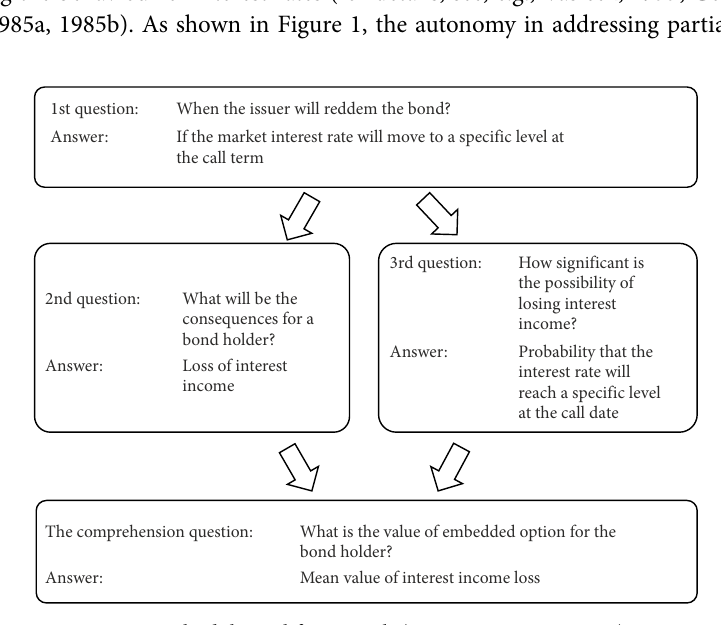
Figure 1. Methodological framework (source: own